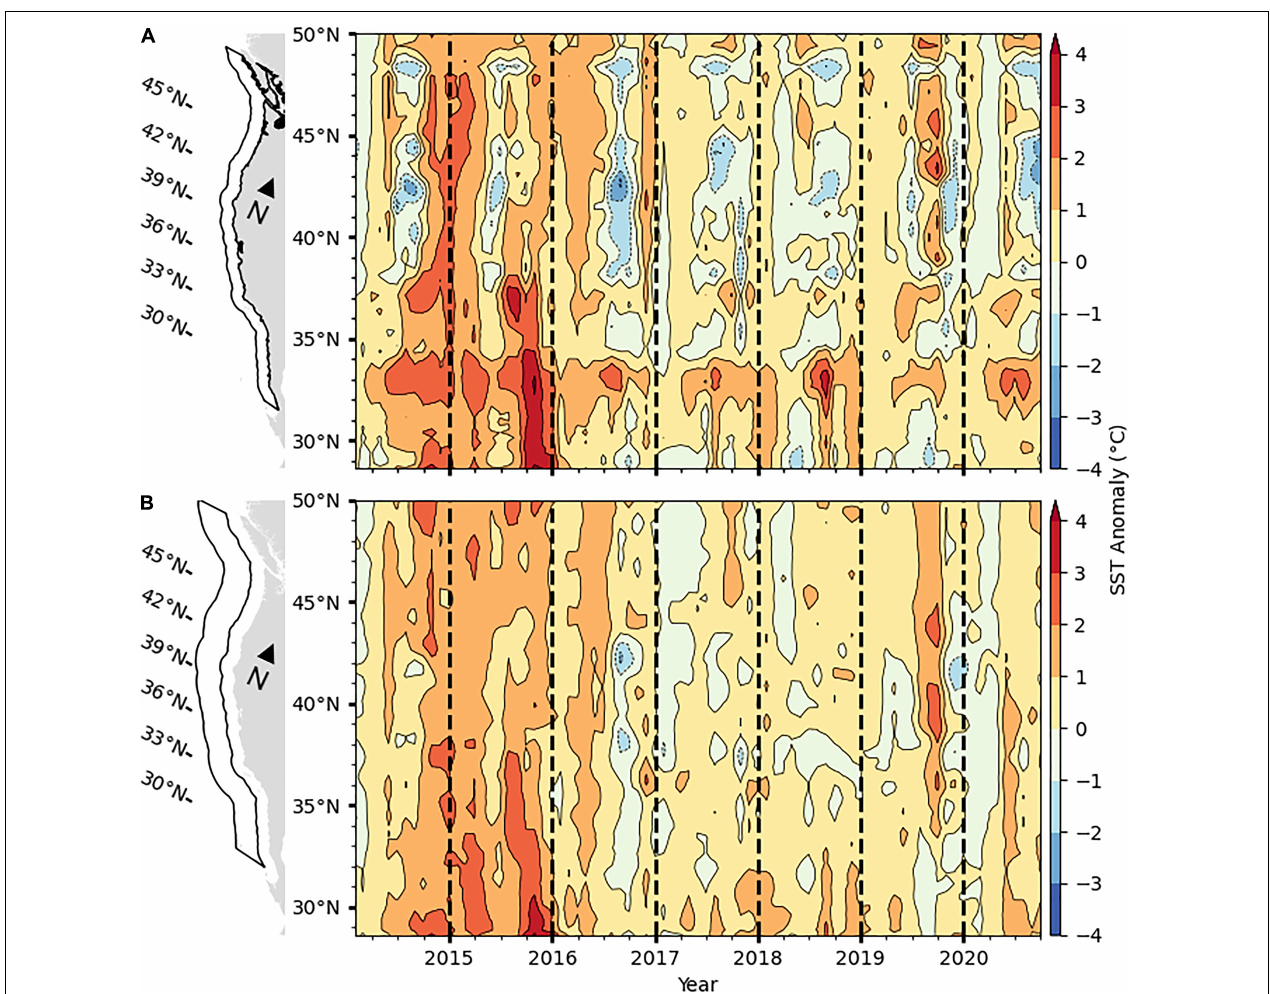
FIGURE 4 | Sea-surface temperature anomalies in the CCS for the period January 2014 to September 2020 in panel (A) the coastal region 0–100 km from the coast, and (B) the transition zone, 100–300 km from the coast. Data are from the optimally interpolated global blended AVHRR temperatures data set version 2.0 (Reynolds et al., 2007) and anomalies are relative to 1982–2010 monthly means. Black contour lines mark anomalies at 1 ◦ -C